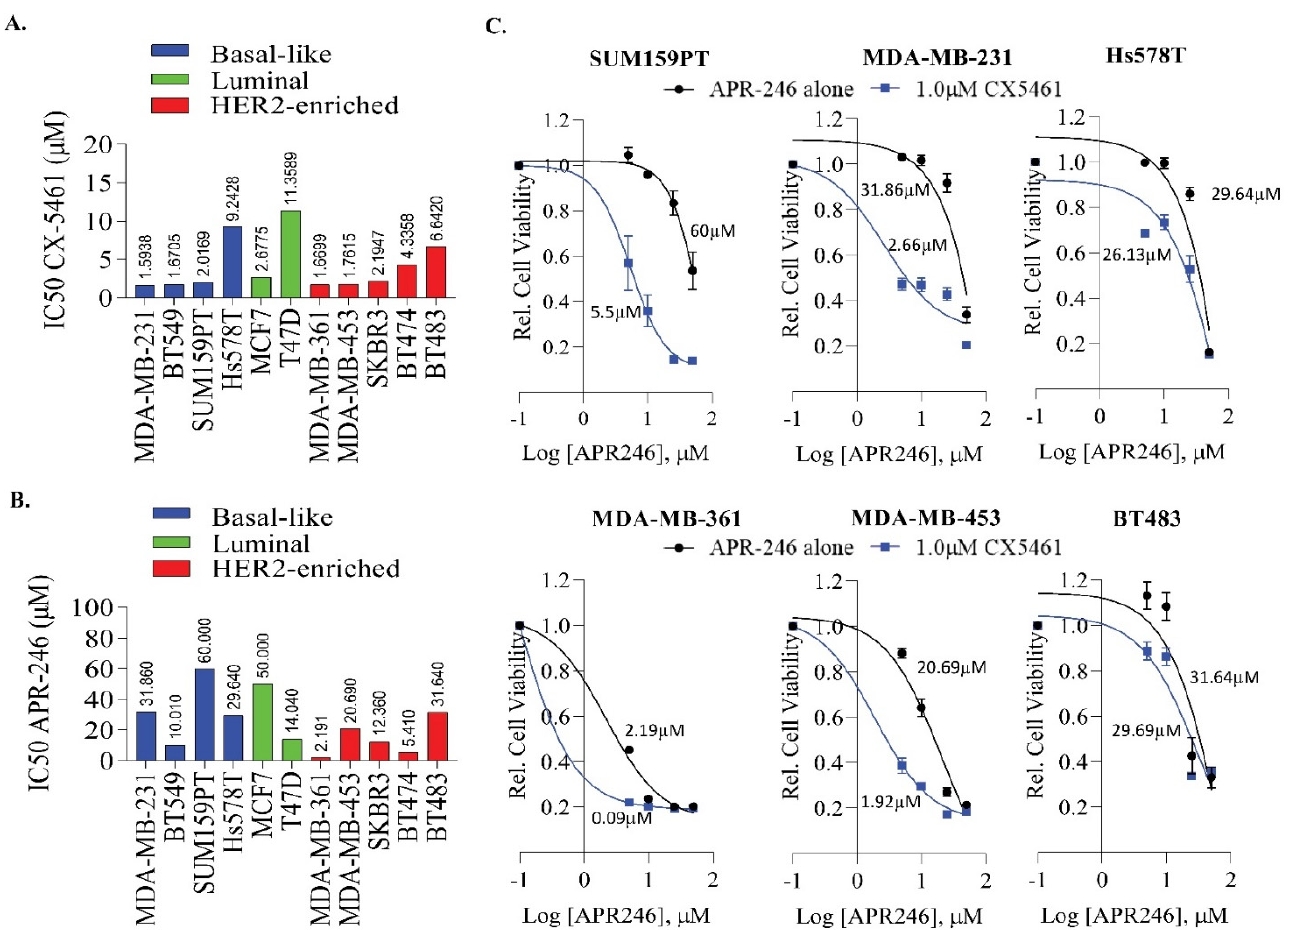
Figure 2. Impact of CX5461 and APR-246 treatment on cell growth in a panel of breast cancer cell lines. ( A ) A panel of breast cancer cell lines were used to determine the IC50 value of CX-5461. Cells were exposed to different concentrations of CX-5461 and cell viability was determined after 6 days, using MTS assays. The dose-response curve was generated by calculating cell viability relative to untreated control and plotted against drug concentration, n = 2–3 experiments and data were pooled together to generate IC50. ( B ) The IC50 of APR-246 was determined in a panel of breast cancer cell lines. ( C ) Representative cell lines as indicated in the figure were exposed to different concentrations of APR-246 (5–25 µM) alone or in combination with 1 µM of CX-5461 and cell viability was determined as described in A.